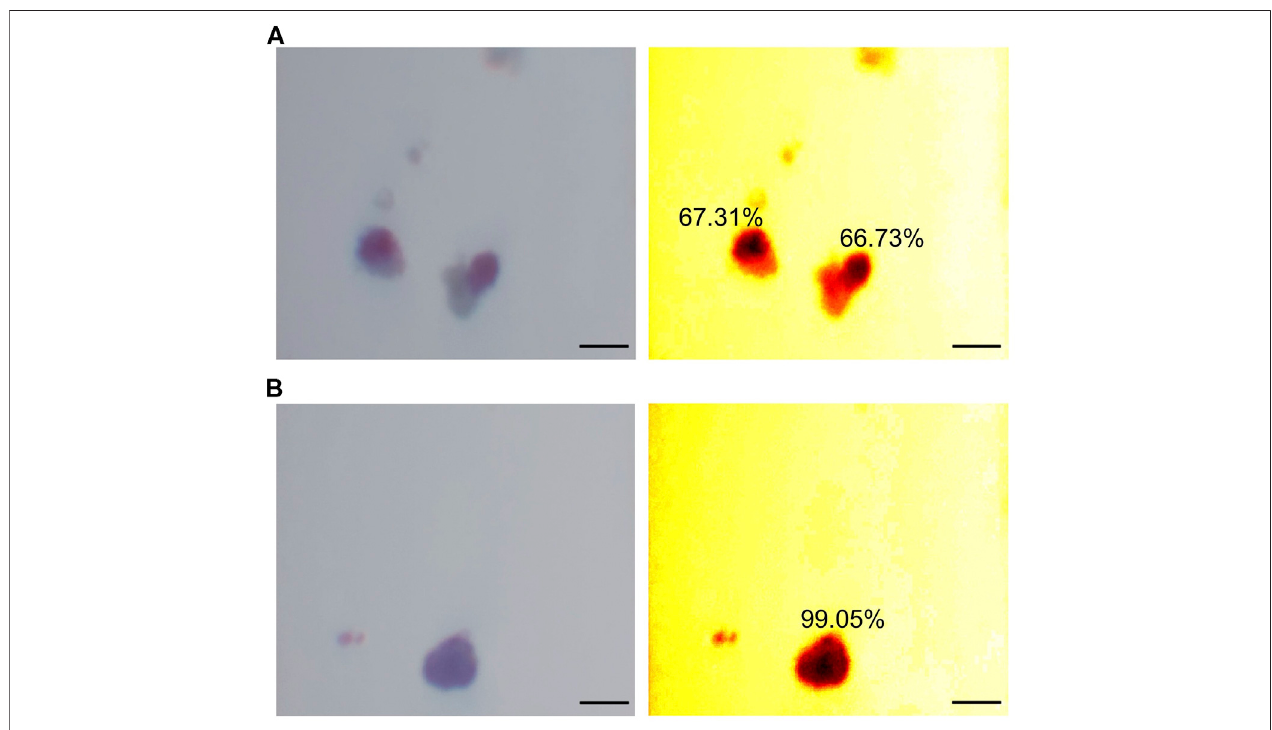
FIGURE 5 | Demonstration of trapped islet percentage. (A) Example of two trapped islets. (B) Example of a free islet. The two images on the left are raw images taken from the smartphone camera. The two images on the right are heatmaps of HSV color space. Scale bar (cid:1) 200